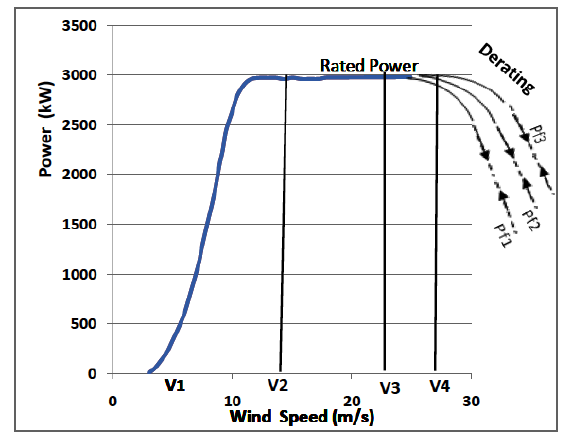
Figure 3. Modified wind turbine power